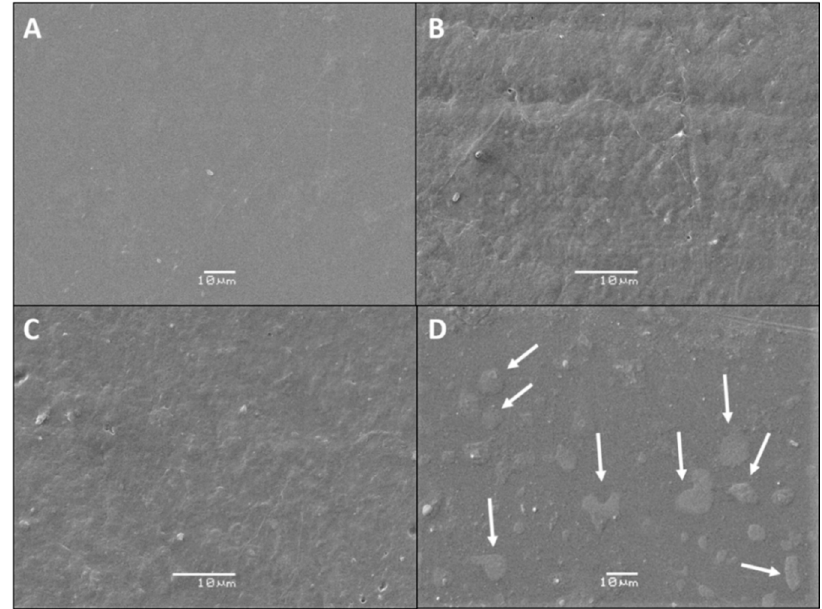
Figure 2. Scanning electron microscopy (SEM) micrographs of: ( A ) PLA, ( B ) PLA-E5, ( C ) PLA-E10, and ( D ) PLA-E15. White arrows indicate the presence of stilbene-rich extract agglomerates on the biopolymer film